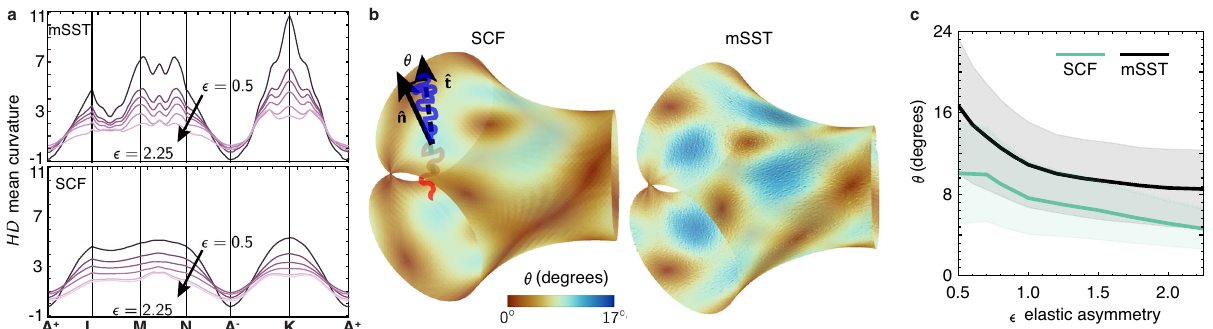
Fig. 5 Finite- versus in fi nite-segregation models of domain shape and packing. a Band diagrams showing local mean curvature H along the path de fi ned in Fig. 1d of the IMDS of a DG calculated via medial SST and SCF. b Maps of chain tilt at the IMDS for SCF and medial SST (mSST) at ϵ = 1 and f = 0.3 with ( c ) the corresponding dependence of tilt-angle distributions for DG morphologies along the F (Lam) = F (Hex) line (center line gives the mean value and range shows standard